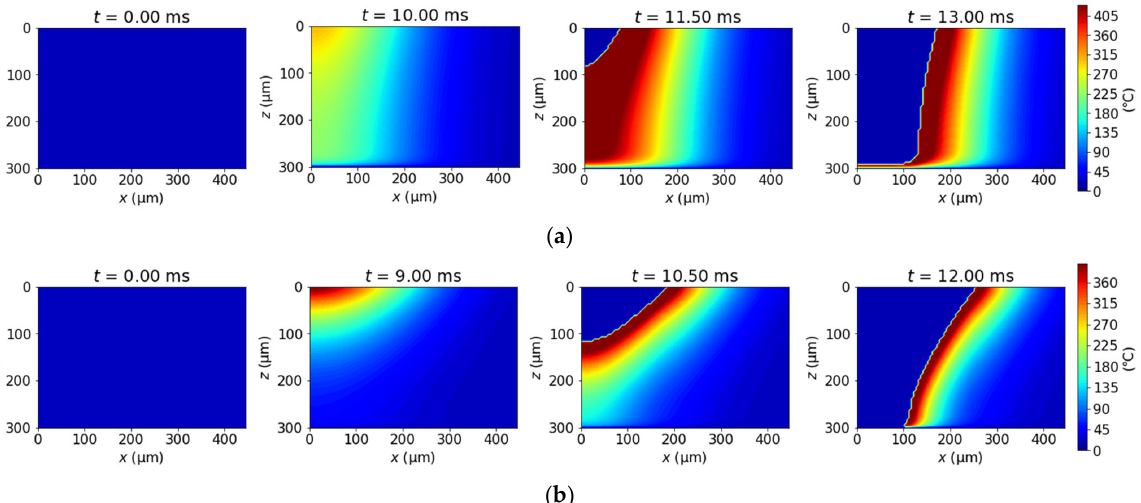
Figure 7. The simulation results of the thermal model of ( a ) PP and ( b ) PET at 167 J/cm 2 . The laser center at t = 0.00 ms is 750 μ m apart from x ‐ z plane.